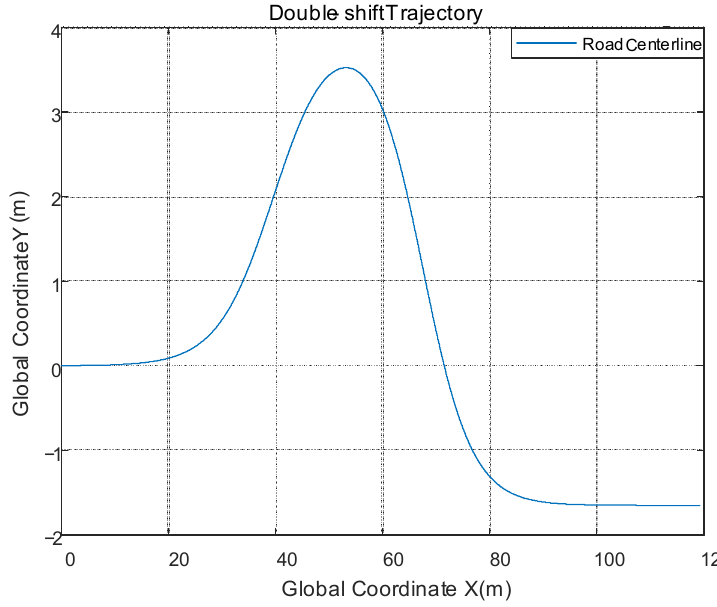
Figure 7. Double shift road